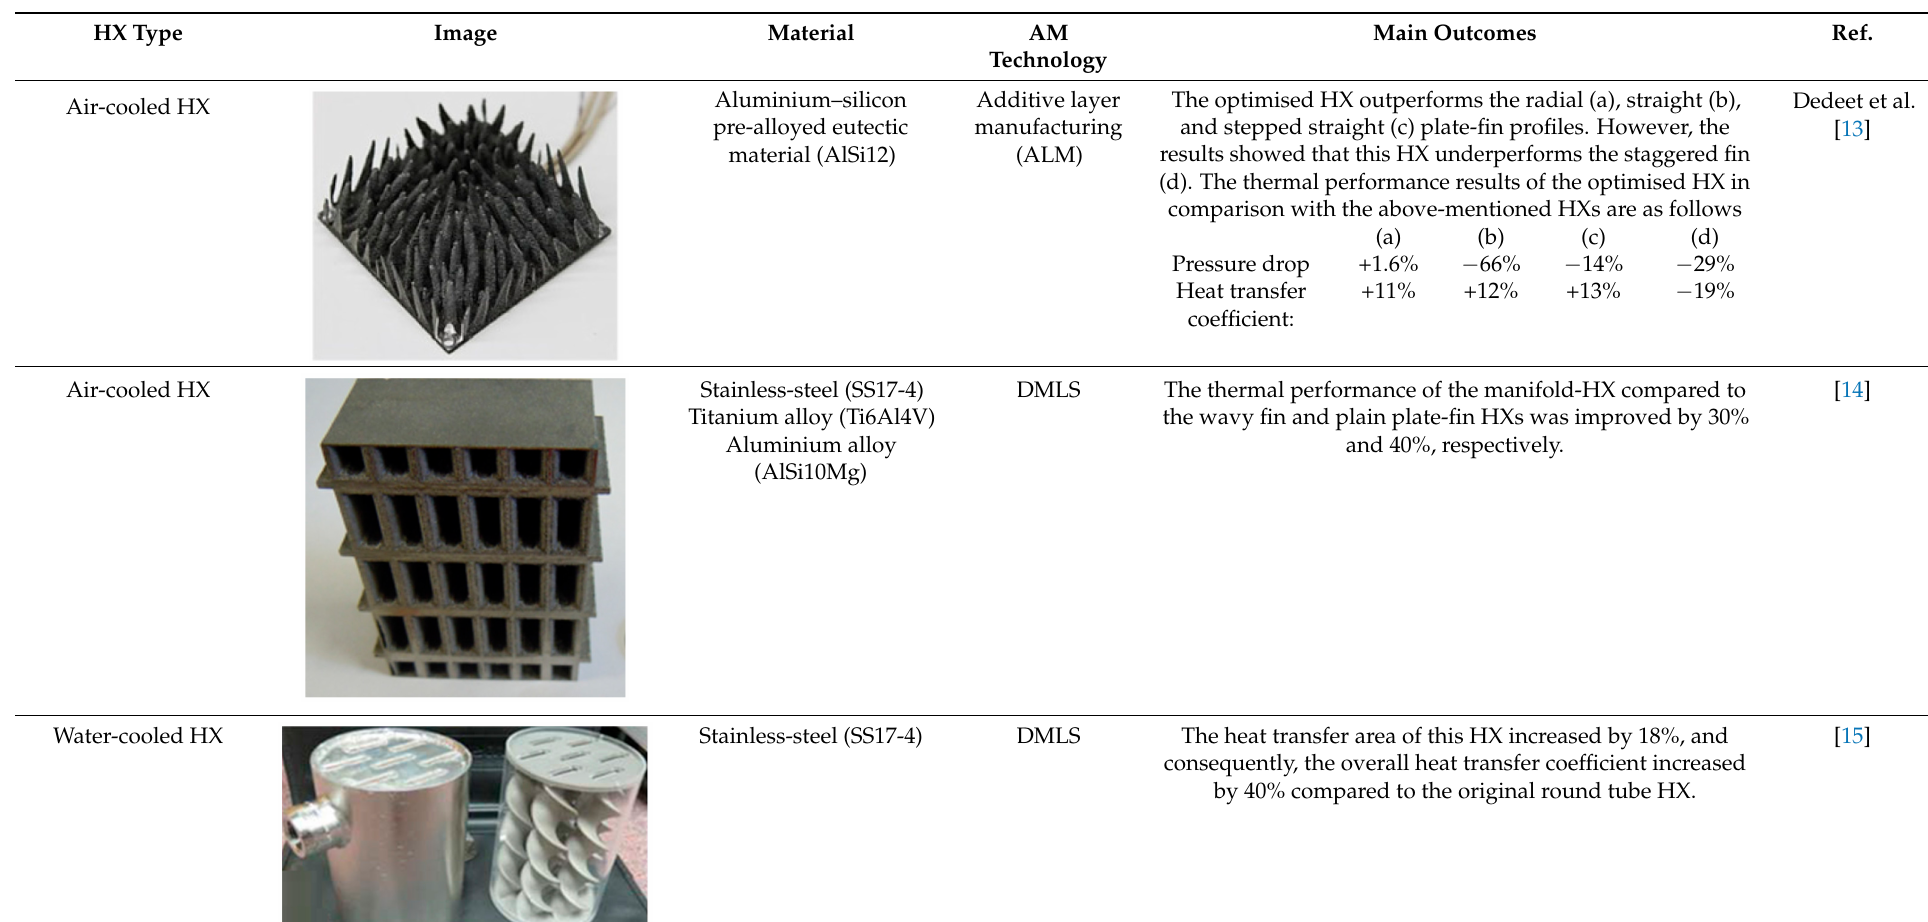
Table 1. Recent published studies on additively fabricated heat exchangers